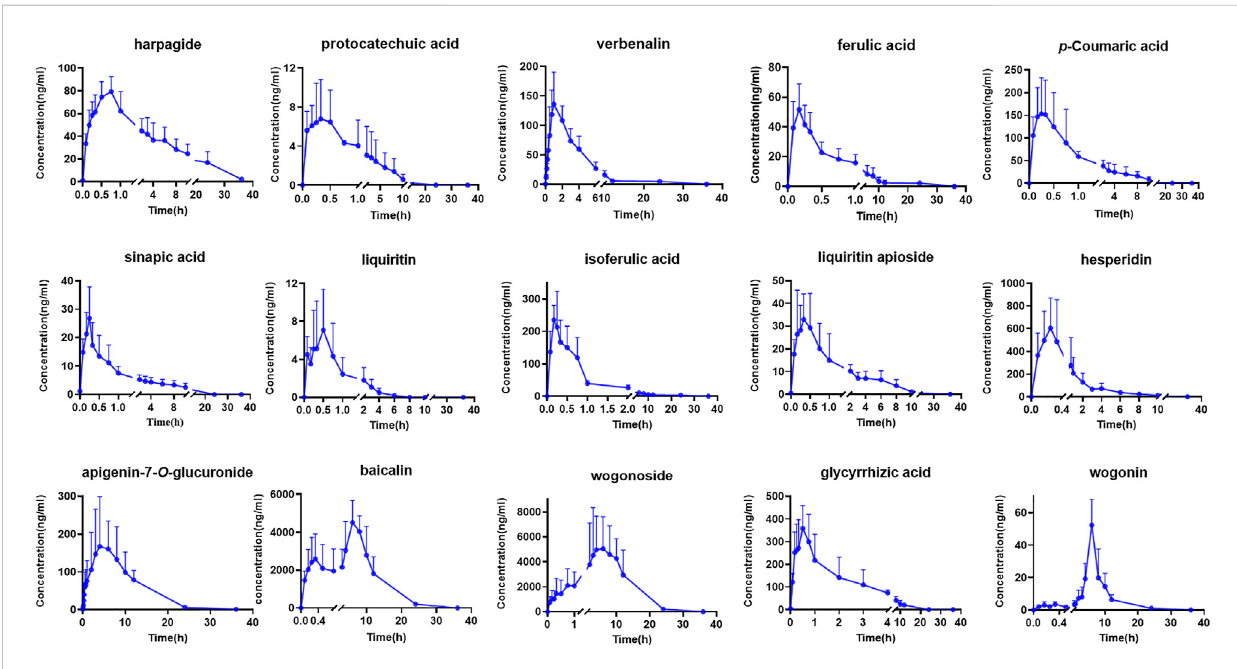
FIGURE 2 The mean plasma concentration-time of 15 compounds in rats after oral administration of QJYQ (n = 8, Mean ± SD).